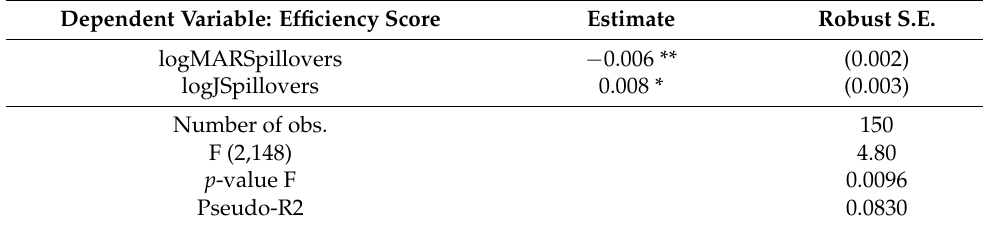
Table 4. Tobit regression: all countries 2002–2017 (average marginal